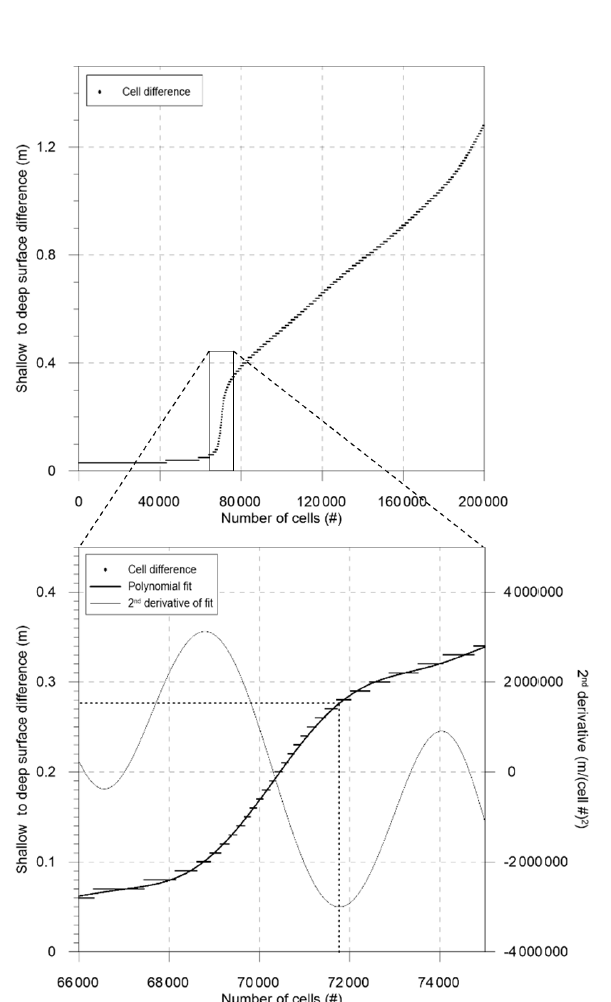
Figure 7. Vertical difference between the shallowest and the deepest lidar point within 0.5m grid cells in the land–water transition zone. The abrupt change is caused by the dead zone. The vertical extent of the dead zone is determined to approximately 28cm, derived by the maximum rate of change of a polynomial fit through the